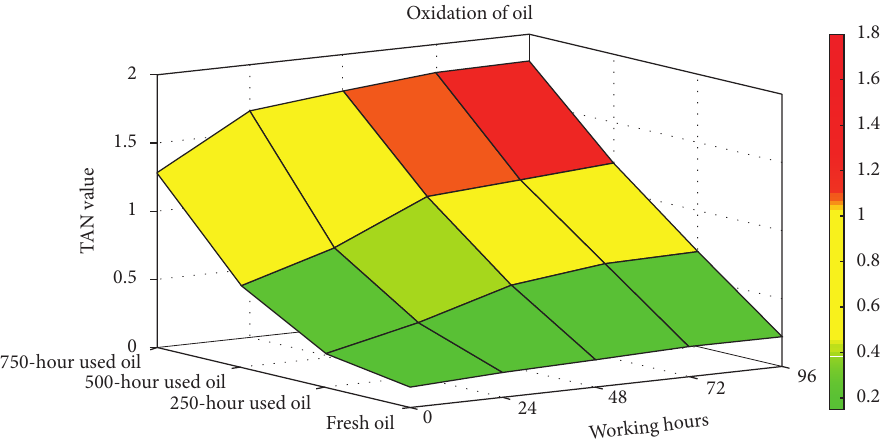
Figure 13: Oxidation curve of HFDU68 oil.